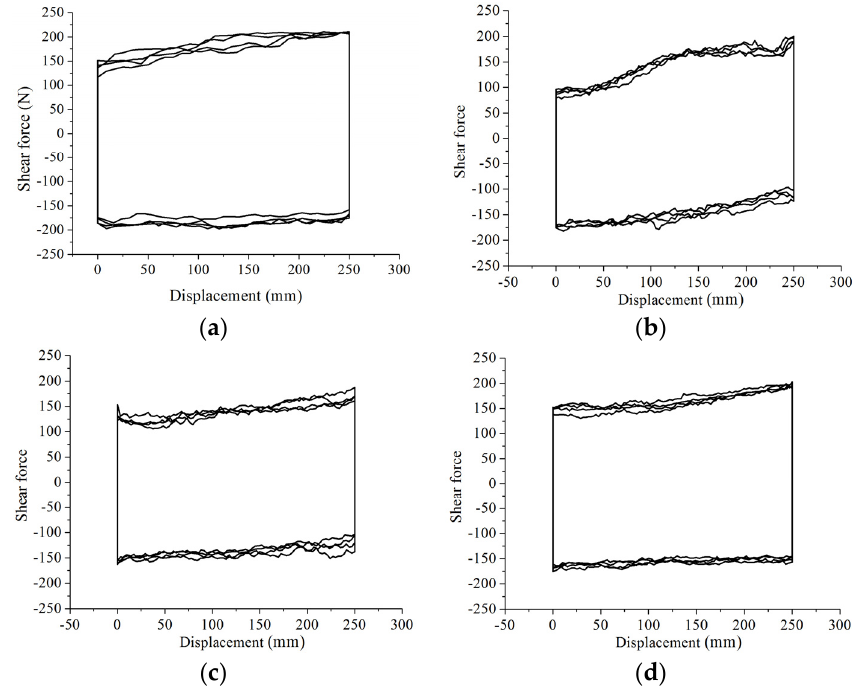
Figure 6. Typical hysteretic loops for the non-interlocking mortarless brick (N-IMB) and IMB joints under four cyclic experimental tests: ( a ) non-interlocking; ( b ) circular interlocking; ( c ) trapezoidal interlocking; ( d ) rectangular interlocking.